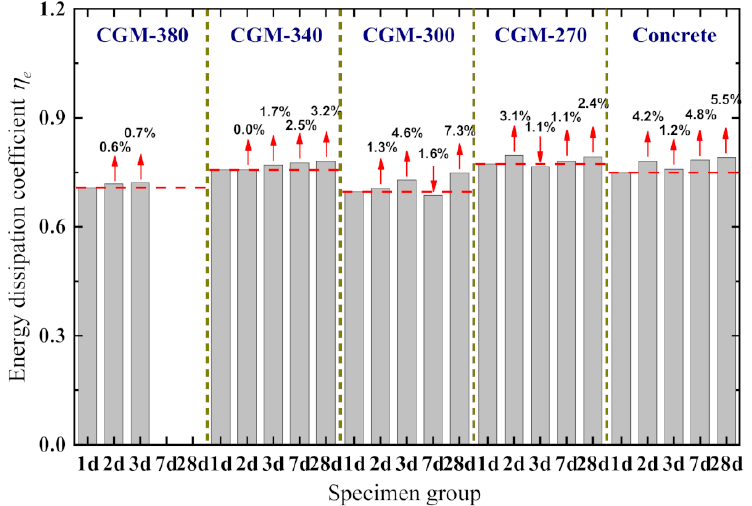
Figure 13. Energy-dissipation coefficient of specimen.